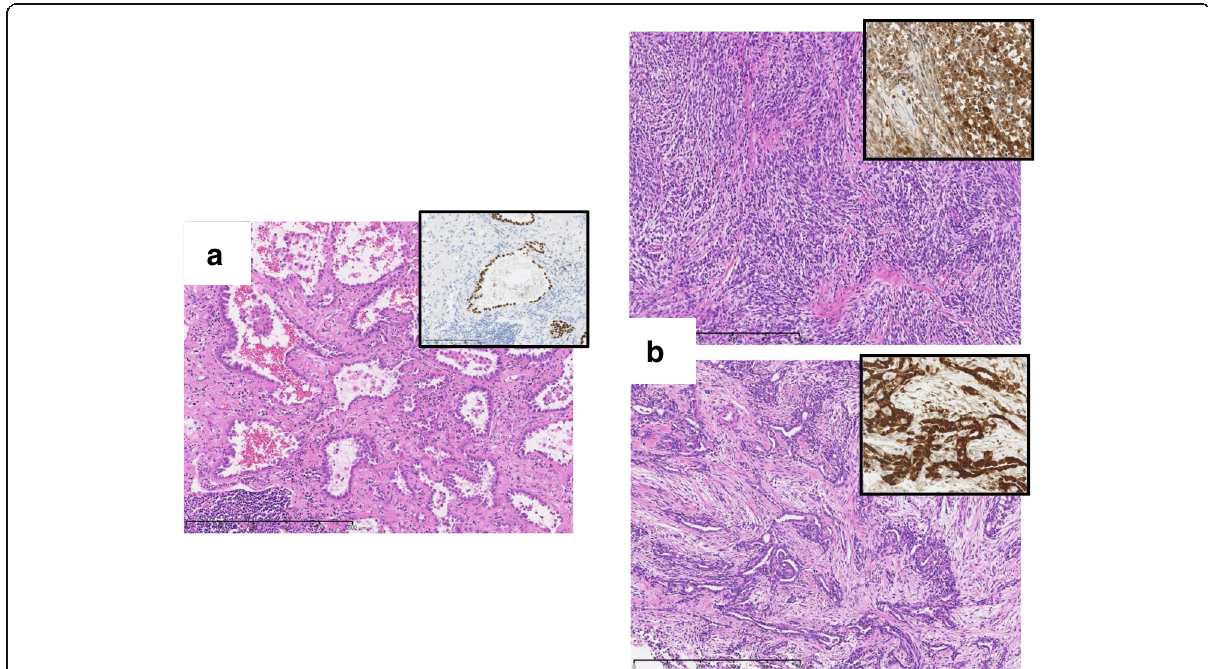
Fig. 3 a Pathological features of left lung tumor showing papillary growth of atypical tumor cells that were positive for thyroid transcription factor-1 (TTF-1). b Pathological features of right pleural tumor showing a combination of sarcomatoid ( upper ) and epithelioid ( lower ) components. Tumor cells of both components were positive for